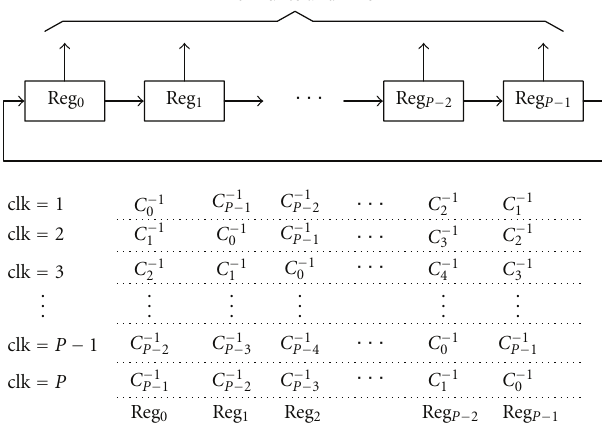
Figure 11: Simplified architecture of inverse C look-up table (ICLUT) and its corresponding outputs values.